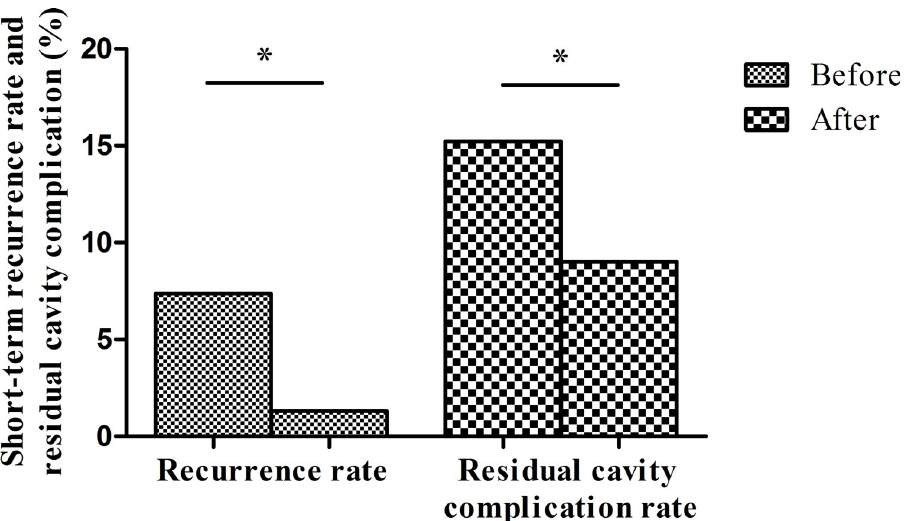
Fig 8. Decreases in short-term overall postoperative recurrences and residual cavity complications after program implementation. Recurrences decreased from 7.4% to 1.3%, while residual cavity complications decreased from 15.2% to 9.0%. ( � p < 0.001 by the chi-square test).